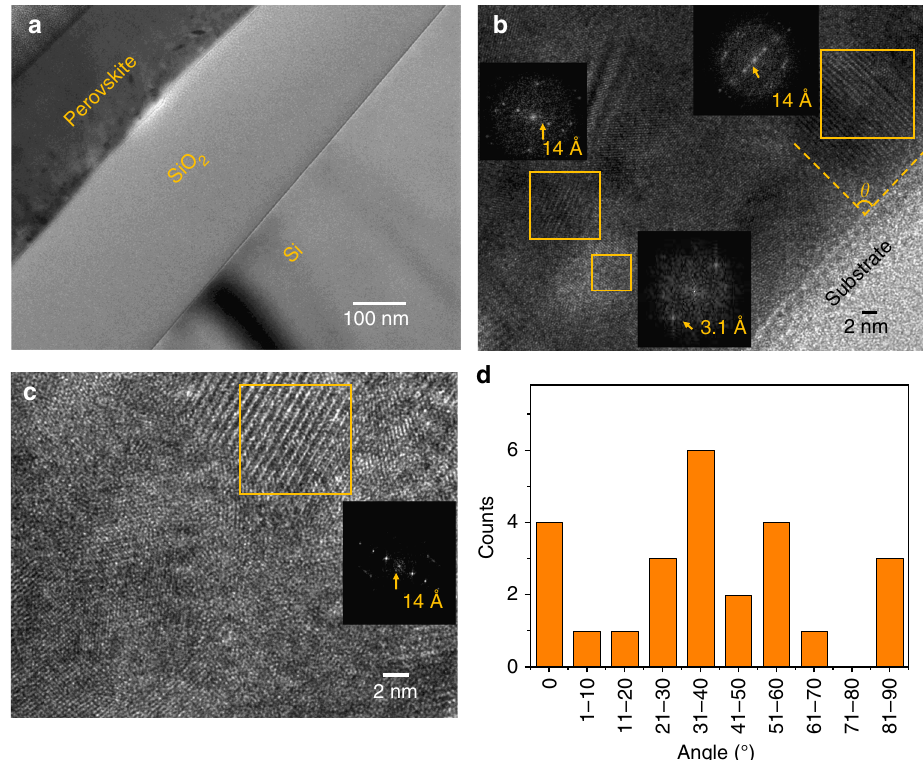
Fig. 4 High-resolution transmission electron microscope (HRTEM) images of cross-section of the spin-coated BA 2 MA 3 Pb 4 I 13 thin fi lms. a – c TEM images of the cross-section of the thin fi lm at different locations and different magni fi cations. Inset: images of the fast-Fourier transforms (FFT) of the area in yellow square. d Statistical distribution of the angle θ between substrate and layered